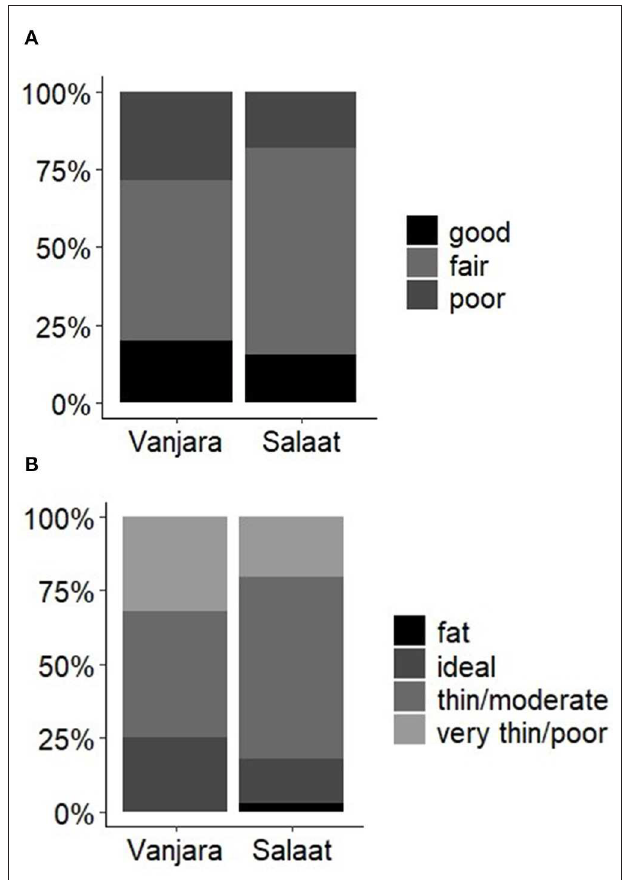
FIGURE 1 | Percentage of donkeys that obtained (A) “good,” “fair,” and “poor” general health scores and (B) each body condition score, grouped by the ethnic group of the donkey owner.